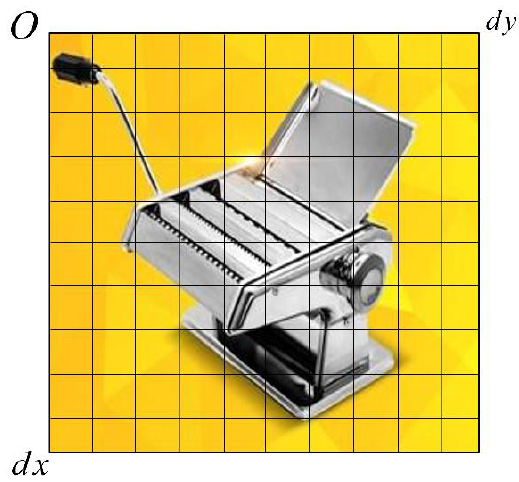
Figure 4. Establishing the world coordinate system.